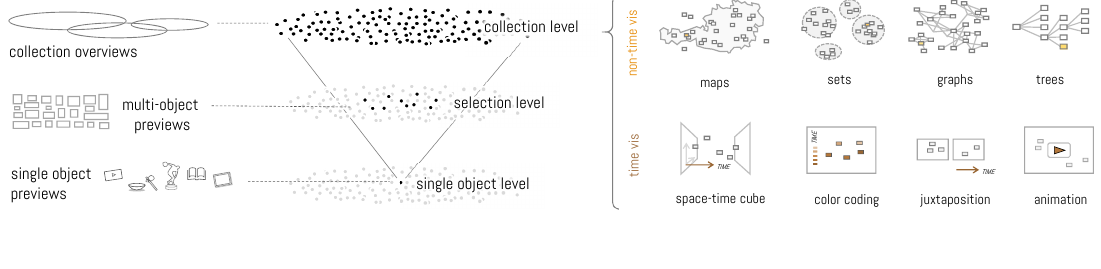
Figure 3. Overview visualizations of cultural collections (top) are frequently using discrete object symbols (glyphs) within multiple views (top right) and encode time in various fashions (bottom